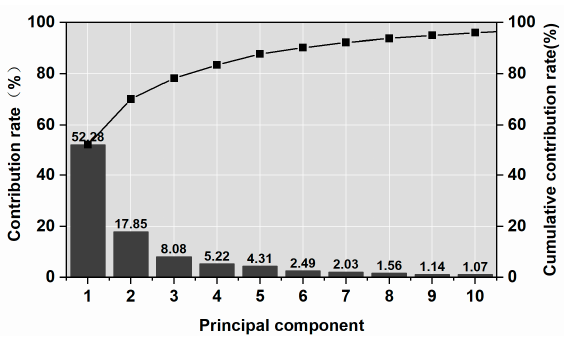
Figure 7. Result of PCA algorithm principal component cumulative contribution.